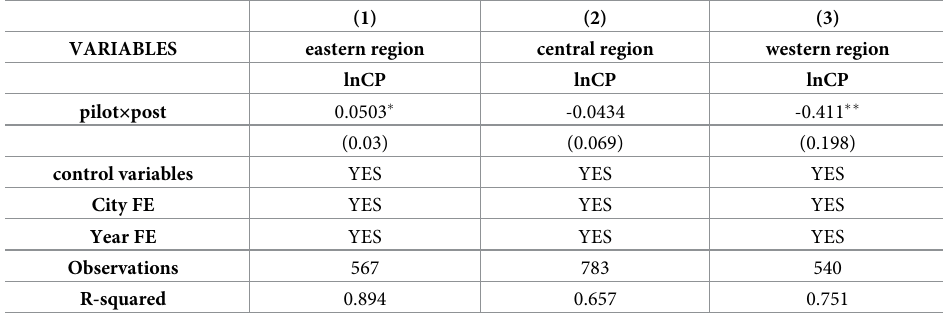
Table 4. Regional heterogeneity analysis.